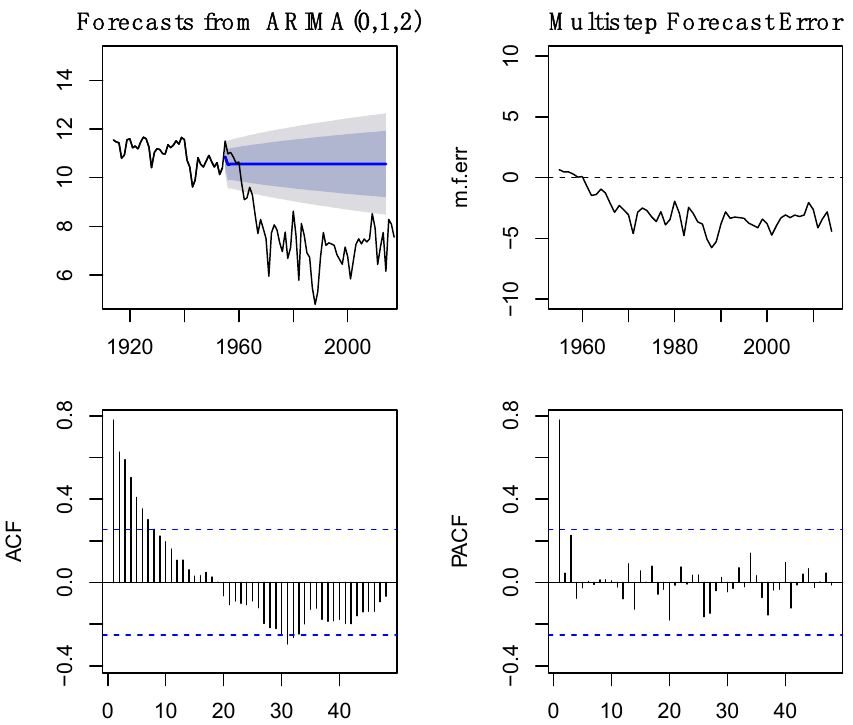
Figure 3. Forecast of captures without dam construction using the ARIMA models based on pre-intervention capture data for Alosa alosa . Model accuracy was evaluated through its multistep error, ACF, and PACF. Forecasts are shown by the blue line and shaded grey areas.